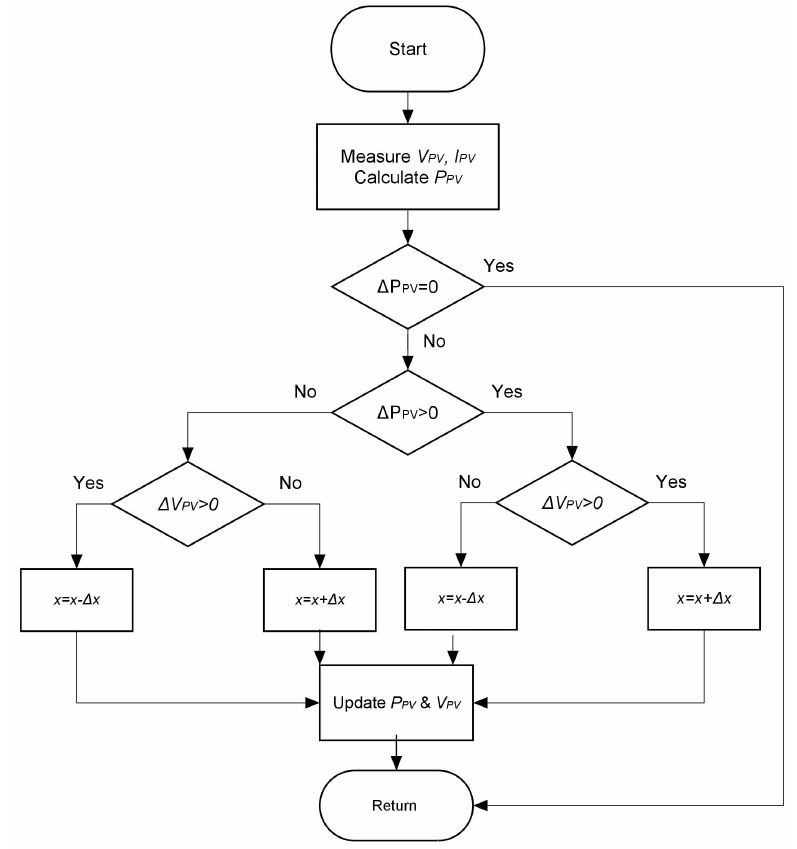
Figure 4. Flowchart of the standard Perturb and Observer (P&O) method